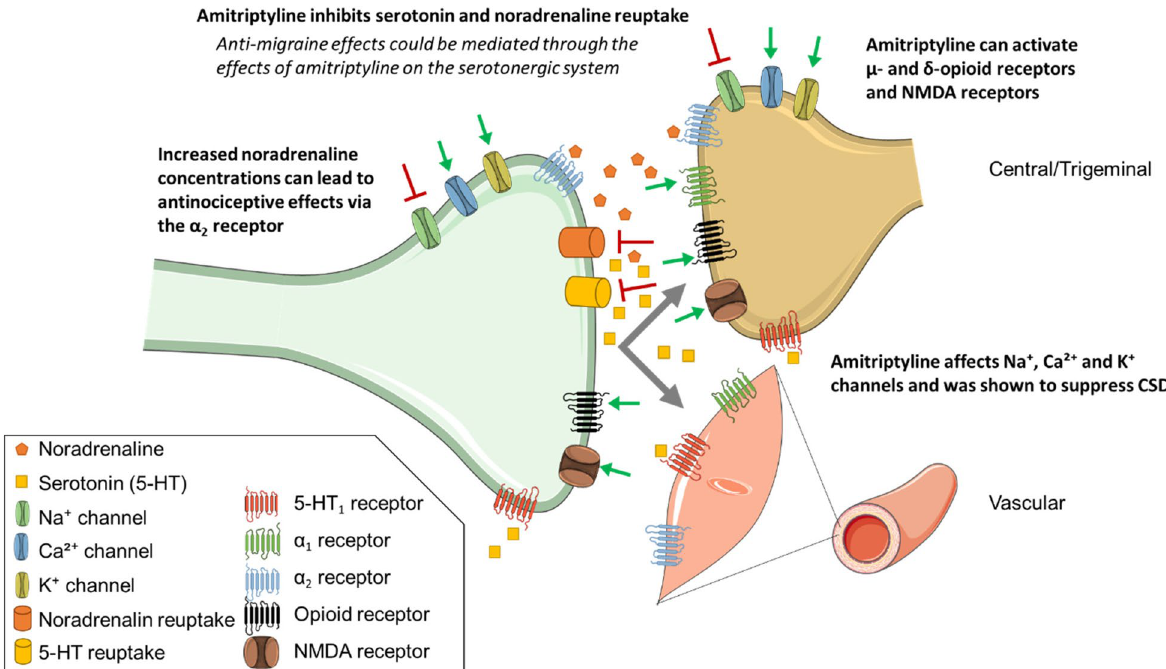
Fig. 1 Potential mechanisms of action for the anti‑migraine effect of the tricyclic antidepressant amitriptyline. Amitriptyline inhibits the uptake of serotonin and noradrenaline in the synaptic cleft, and possibly exerts its antimigraine effects by affecting serotonergic transmission or through antinociceptive effects via activation of the α2 adrenoreceptor [8]. In addition, tricyclic antidepressants affect sodium [14] calcium [10] and potassium [11] channels, exert an effect on adrenergic α1, NMDA and opioid receptors [12] and suppress cortical spreading depression (CSD), which could be underlying migraine aura